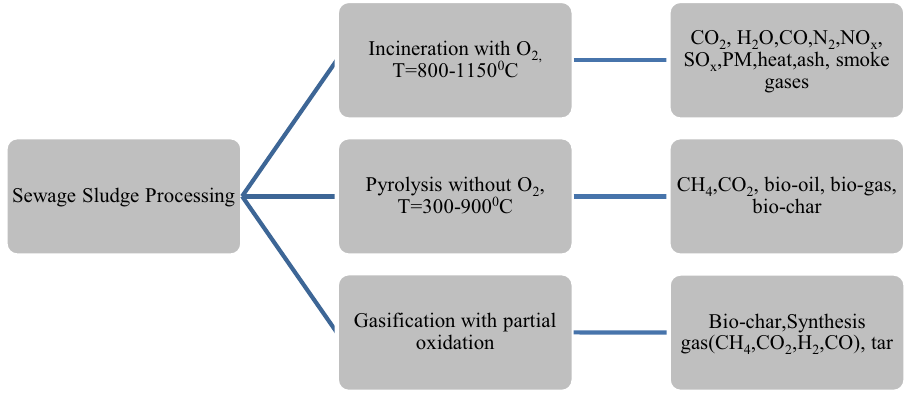
Fig. 3 Different methods of enegy recovery from sewage sludge and their products [74]